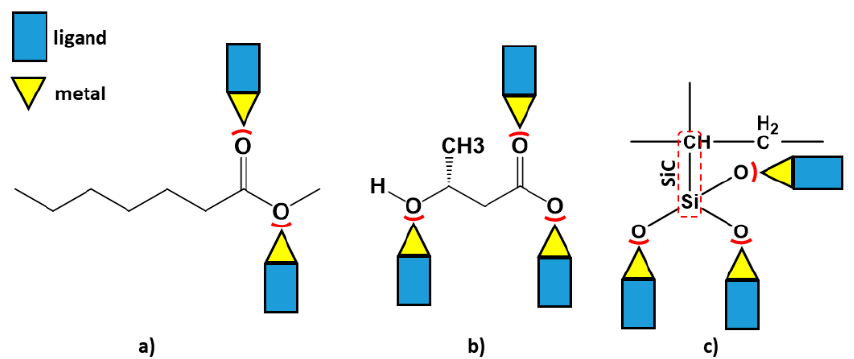
Figure 10. Coordination model of ( a ) C1, ( b ) C2 and ( c ) C3.